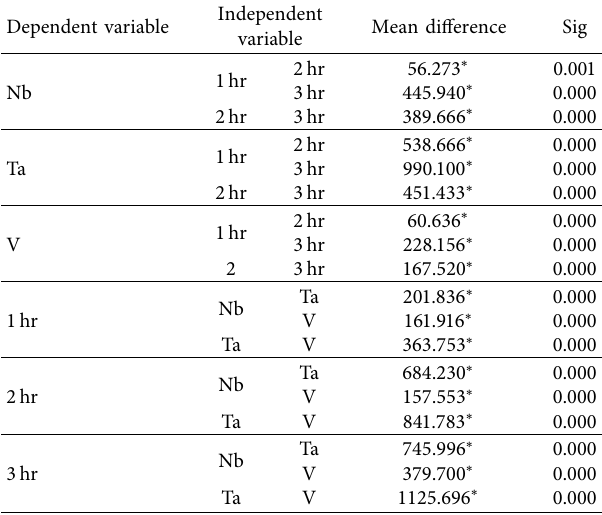
Table 3: Multiple comparisons of nanocoating thickness at dif- ferent sputtering times (1, 2, and 3 hours) and for diferent coating materials (Nb, Ta, and V) using Tukey’s post hoc tests.